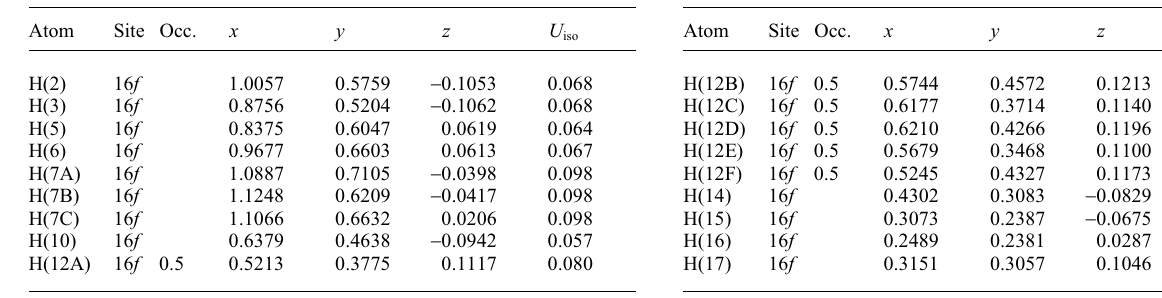
Table 2. Atomic coordinates and displacement parameters (in Å 2 ) .